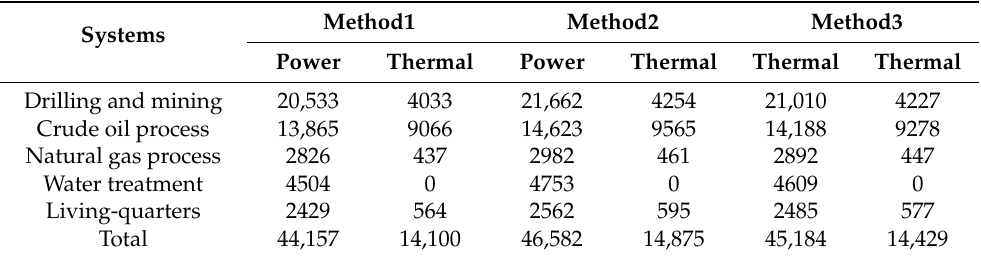
Table 6. Exergy consumption (kW) of OEPS five subsystems using three methods under maximum reference load in